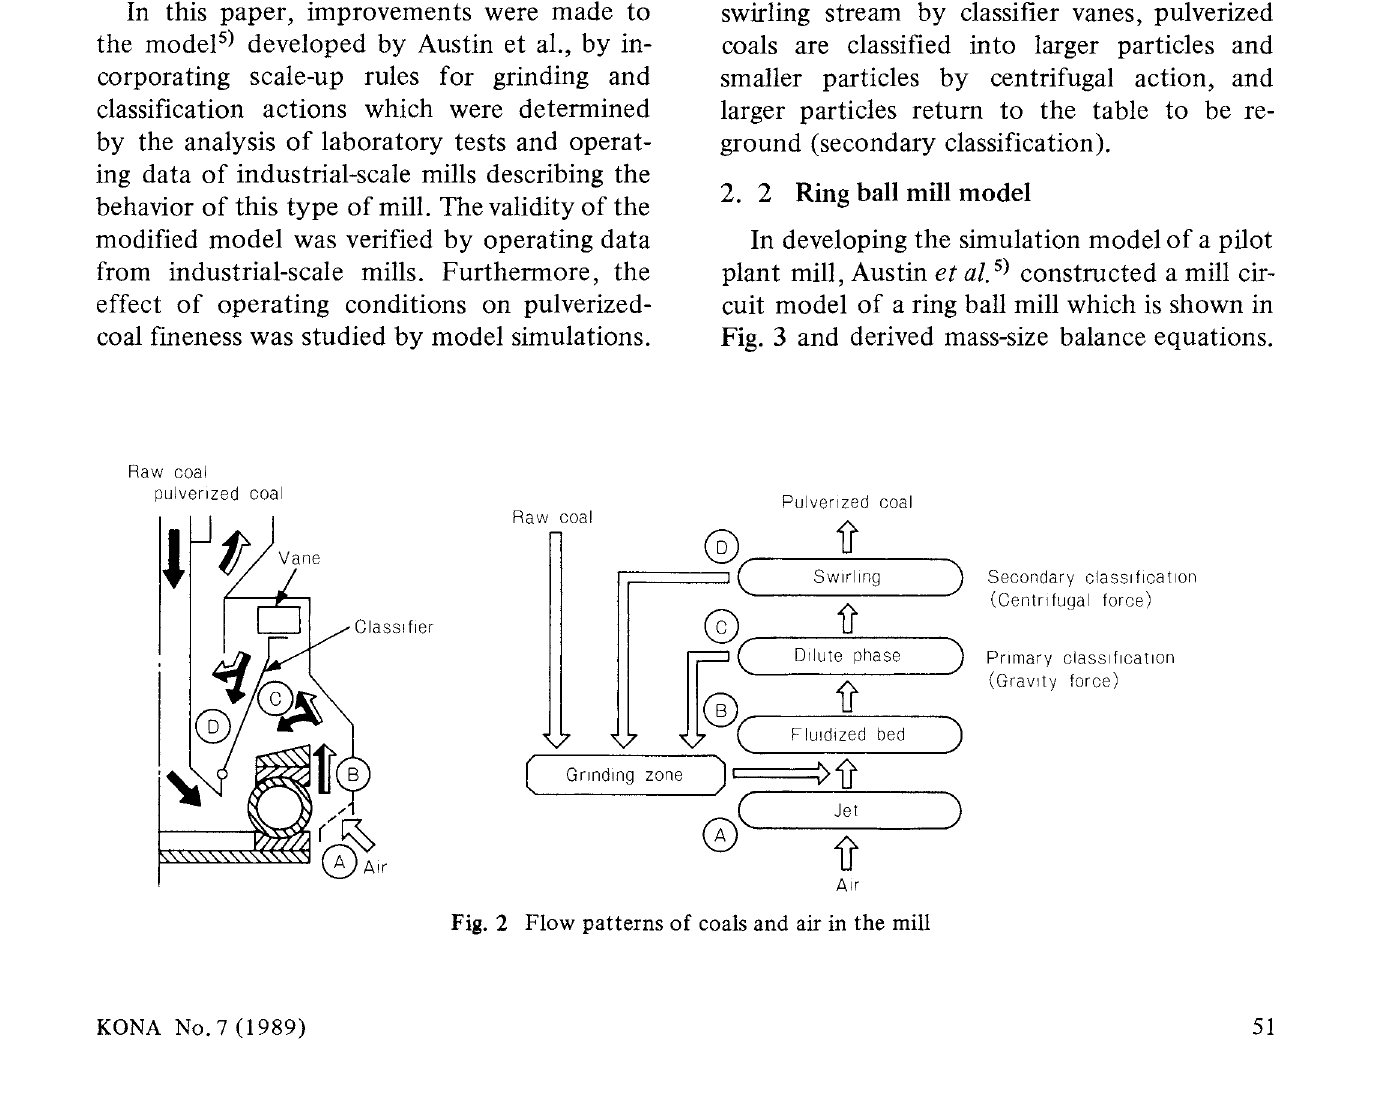
Fig. 2 Flow patterns of coals and air in the